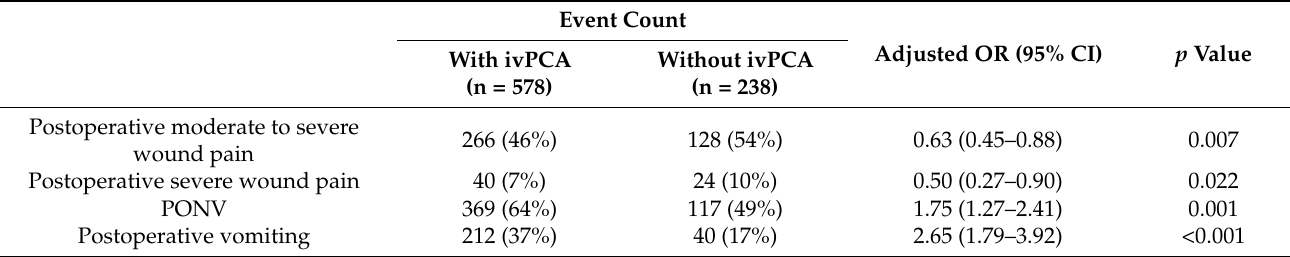
Table 3. Association between ivPCA use and secondary outcomes. Event